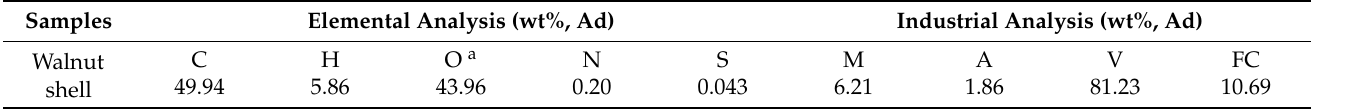
Table 1. Industrial analysis and elemental analysis of walnut